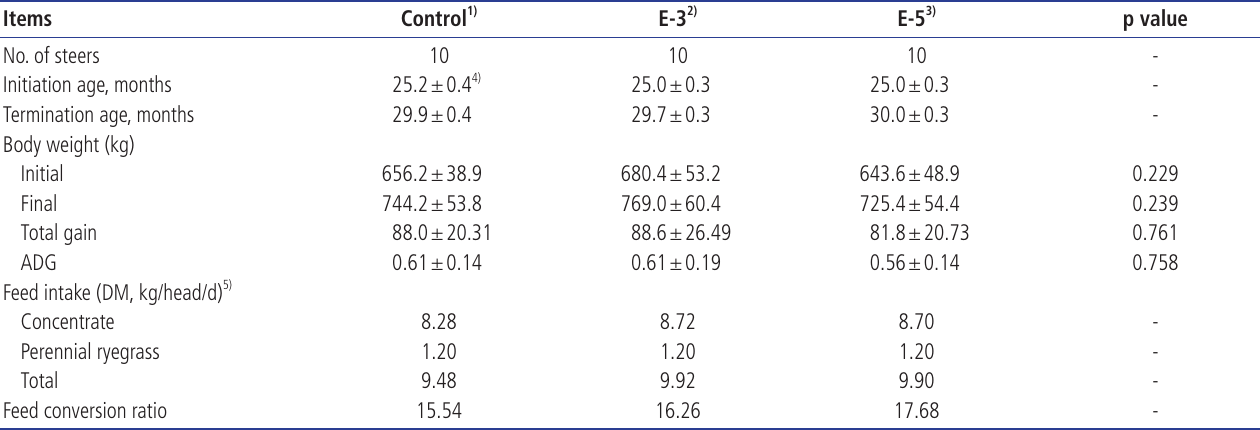
Table 2. Effects of feeding ethanol on growth performances of finishing Korean cattle (Hanwoo) steers